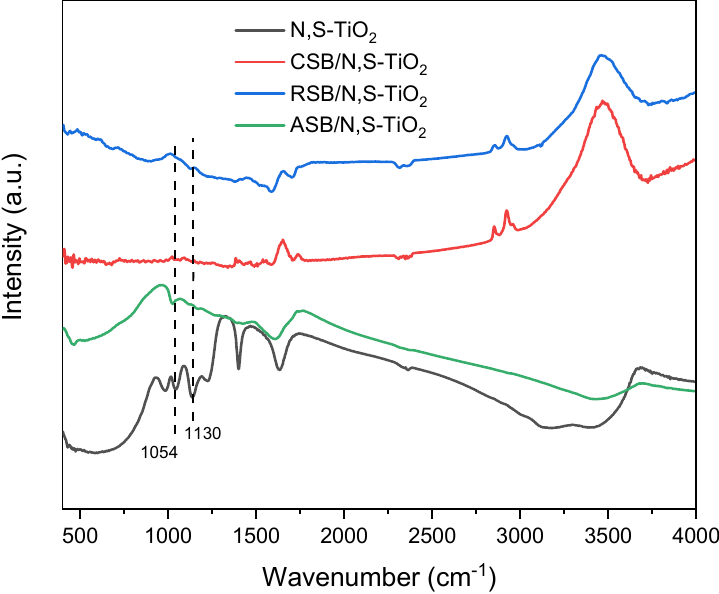
Figure 3. FTIR spectra for N,S-TiO 2 ; RSB/N,S-TiO 2 ; ASB/N,S-TiO 2 ; and CSB/N,S-TiO 2 composite photocatalysts.